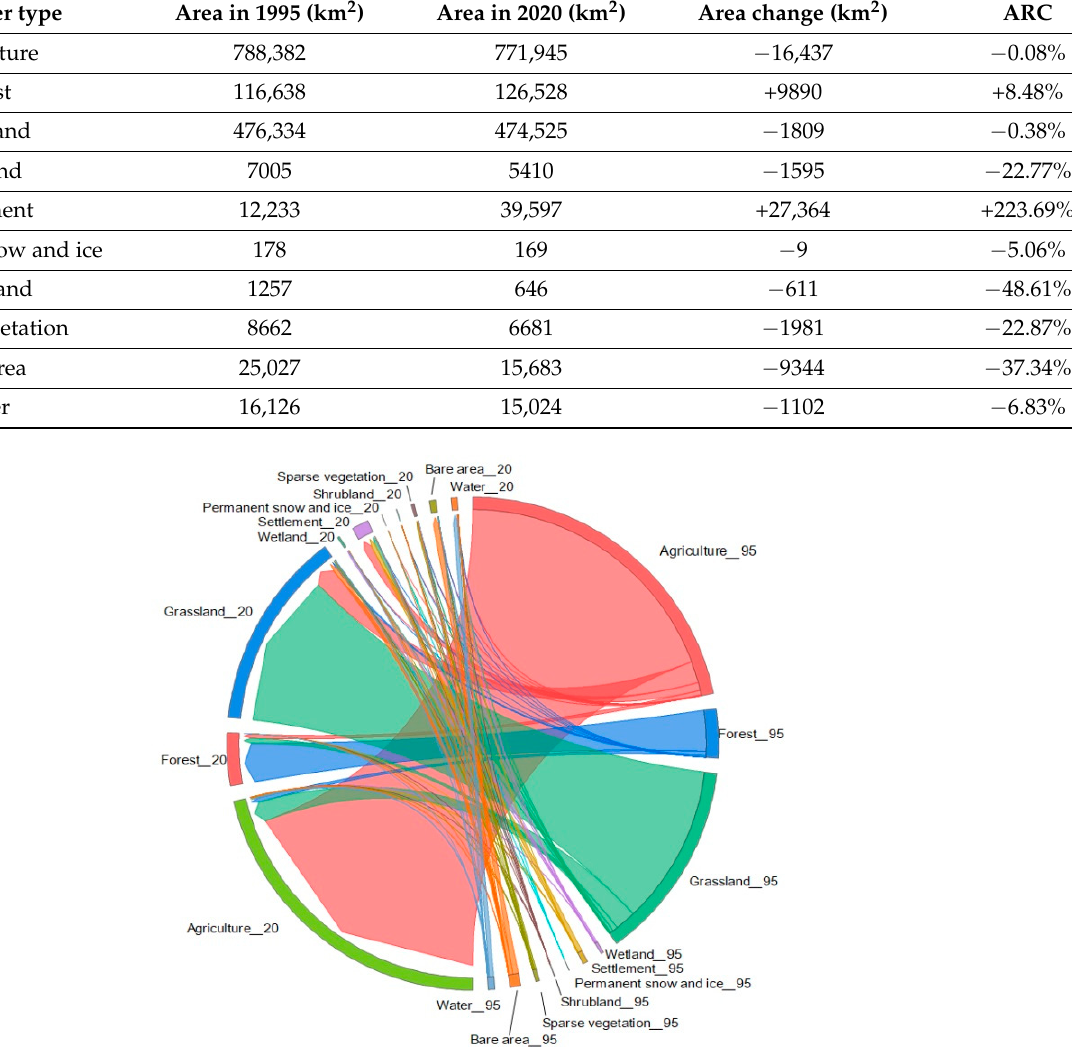
Figure 6. Land cover change in GYRR from 1995 to 2020 using a Chord diagram expression. The right semicircle shows the proportions of different land covers in 1995, and the left semicircle shows the proportions of different land covers in 2020. The arrows in the circle indicate the land cover change.